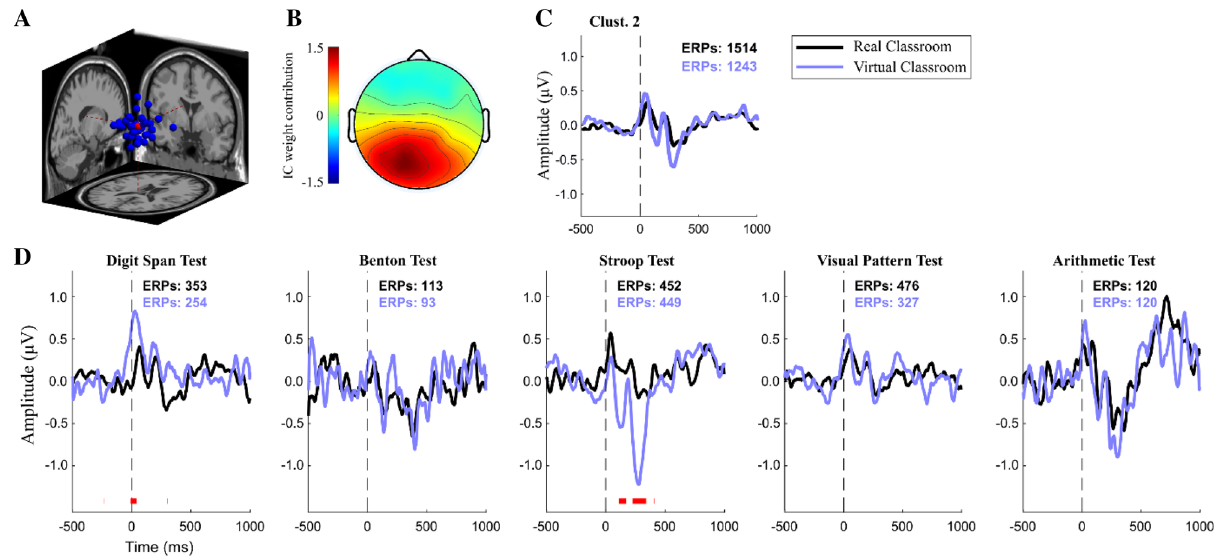
Figure 5. EEG data analysis, showing the ERP characterization of IC Clust. 2 across all cognitive tests. ( A ) Projected equivalent dipole location of the ICs in Clust. 2. ( B ) Scalp map representation of the averaged cluster IC. ( C ) Average waveform for all ERPs in Clust. 2. ( D ) Clust. 2 ERP waveforms for each individual cognitive test. Red marks at the bottom indicate statistically significant difference between environments (p <